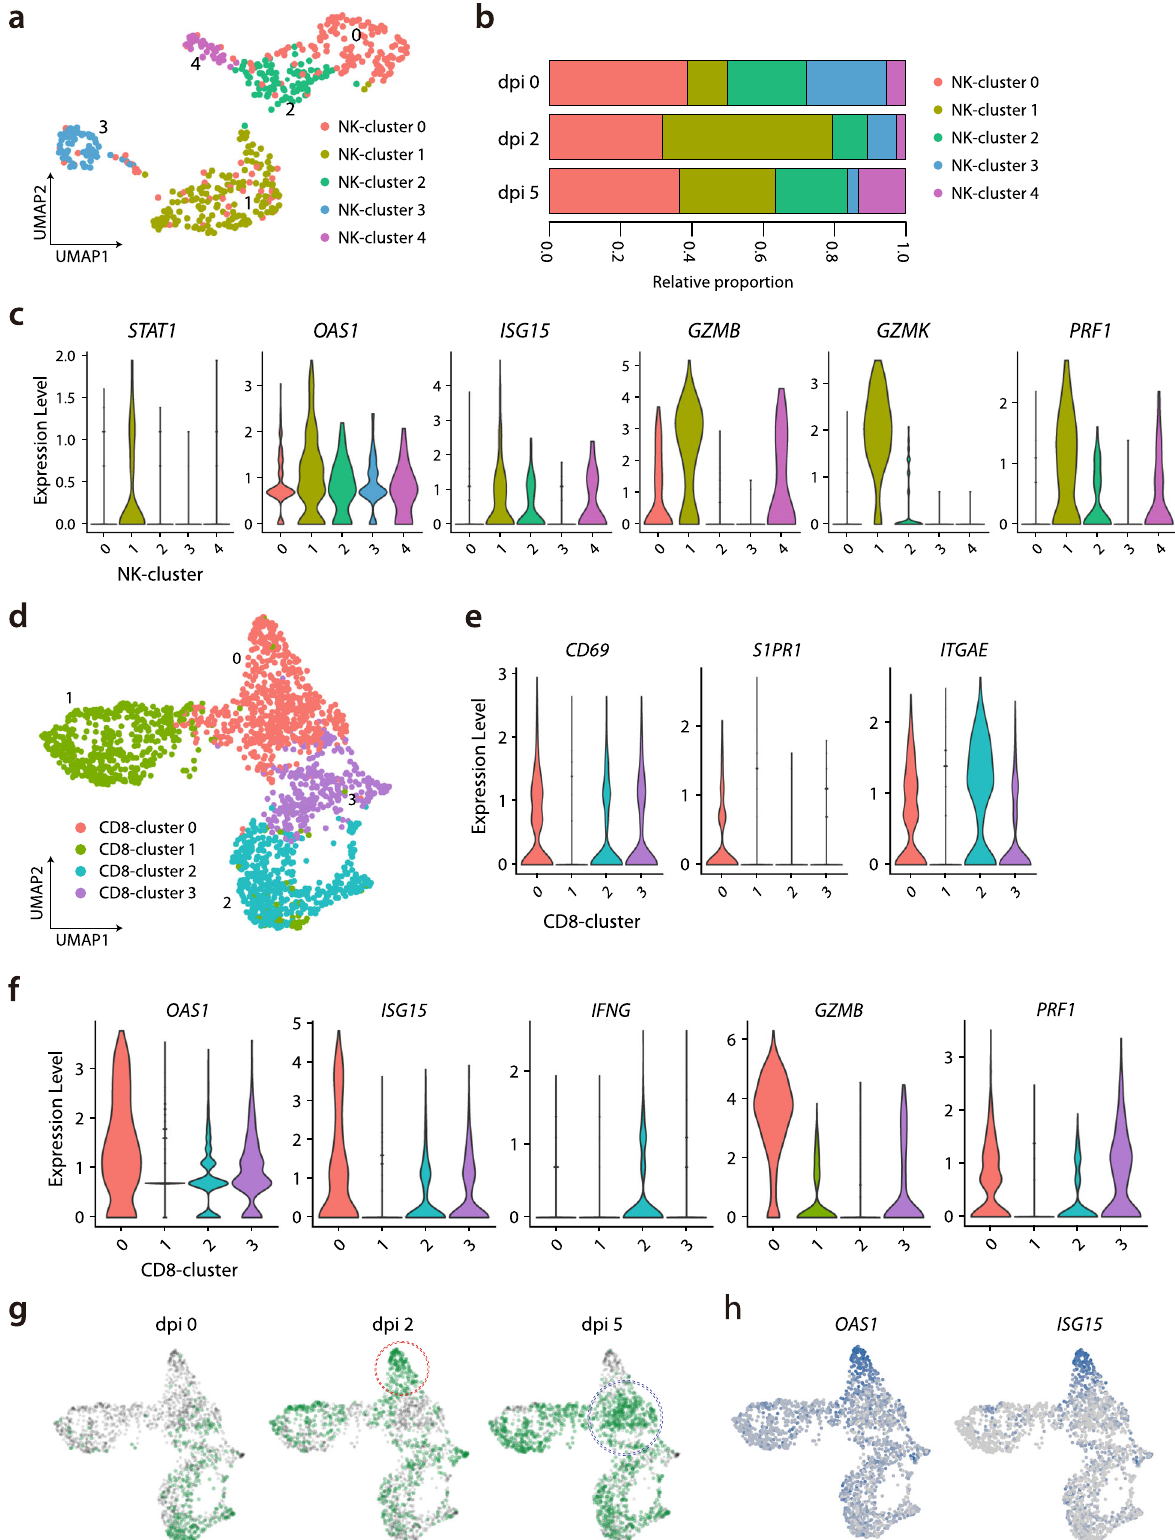
UMAP (Fig. 2d; Supplementary Data 3). The proportion of CD8 + cluster 2 tended to decrease at 2 dpi and to increase at 5 dpi, while the proportion of CD8 + cluster 0 reciprocally changed (Supple- mentary Fig. 4c). When we characterize each CD8 + cluster, CD8 + clusters 2 and 3 exhibited higher expression levels of CD69